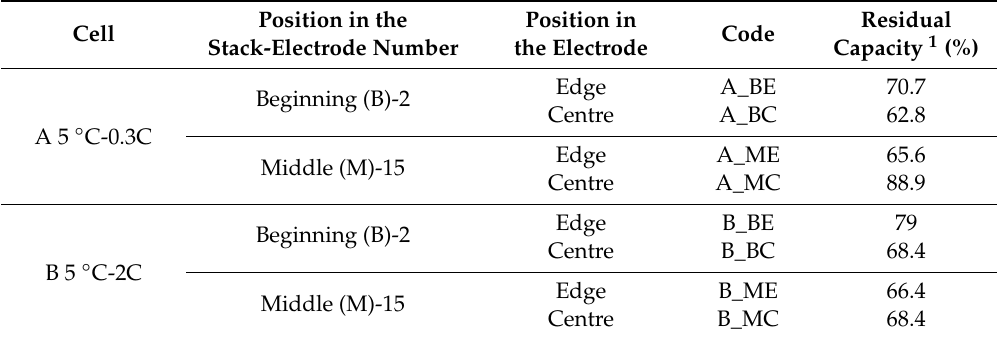
Table 4. Description of sample positioning in the stack and within the electrode, sample coding and residual capacity.